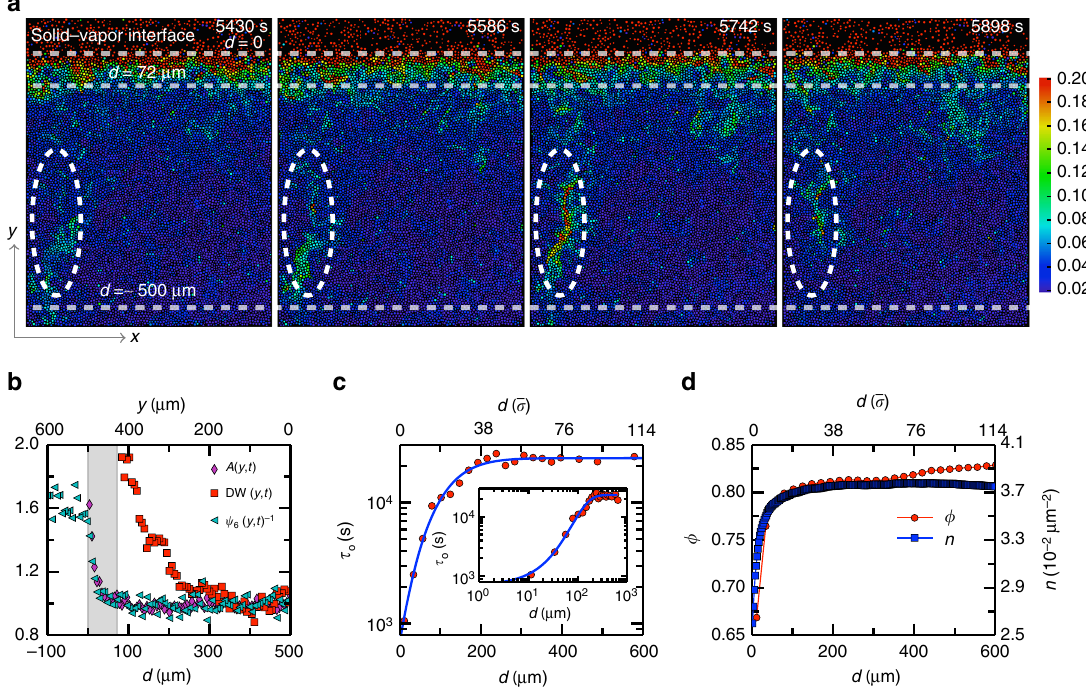
Fig. 2 Surface pro fi les of structural and dynamic properties during vapor deposition. a Surface dynamics of the deposited monolayer glass from 5430 to 5898 s during growth. Colors represent the value of the DW factor of each particle. d = 0 marks the glass-vapor interface. 0 < d < 72 μ m ¼ 14 σ represents the highly mobile surface layer. In the middle layer of 72 μ m < d ≲ 500 μ m, many clusters of large-DW-factor particles, i.e., CRRs, emerged. The dashed ellipses show the evolution of a CRR. The bulk at d ≳ 500 μ m has similar DW values as the middle layer, but much rarer and smaller CRRs. b Average area spanned by Voronoi polygons A ( y , t ), DW factor DW( y , t ) and inverse of the crystalline order ψ 6 ( y , t ) − 1 normalized by the bulk values as a function of depth d . The difference between their pro fi les de fi nes a surface mobile layer at 0 < d < 72 μ m marked by the gray region . At the boundaries of the gray region , DW and A are twice their corresponding bulk values. ψ (cid:2) 1 follows a similar pro fi le as A . The curves are averaged 6 over 100 frames with uniform time steps from 5470 s to 6250 s in Supplementary Movie 1. During such a time period, the surface propagated for about 1.7 particle diameters. c Pro fi le of the mean out-of-cage time τ o ( d ) averaged over all frames. The fi tting curve τ o d ð Þ = τ 0 (cid:4) τ bulk = τ 0 ð (cid:4) ffiffiffi p = 18.1 s is the molecular time scale in vapor phase; τ = 2.3 × 10 4 s is = π (cid:2) 2 x 2 1 (cid:2) erf x ð Þð Þ . erf( x ) is the error function; τ 0 bulk the mean τ o in the bulk; d 0 is the shift of the surface position and ξ is the length scale of CRRs 46 . Inset : The log-log plot. d Pro fi les of the area fraction ϕ and the particle number density n averaged over all frames. The averaged ϕ = 0.813 ± 0.007 in the middle layer and 0.827 ± 0.004 in the